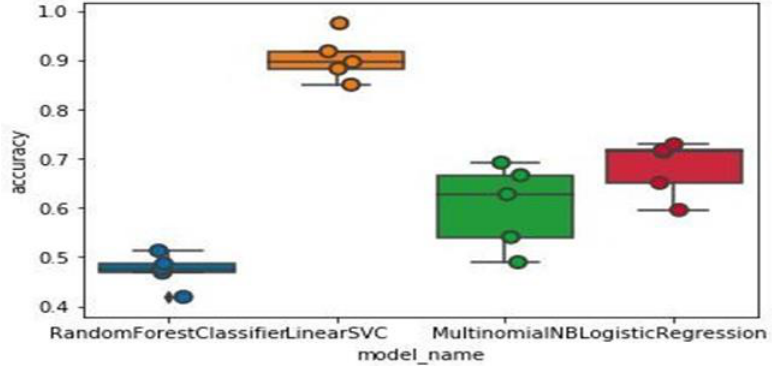
Fig. 5. Accuracy plots of